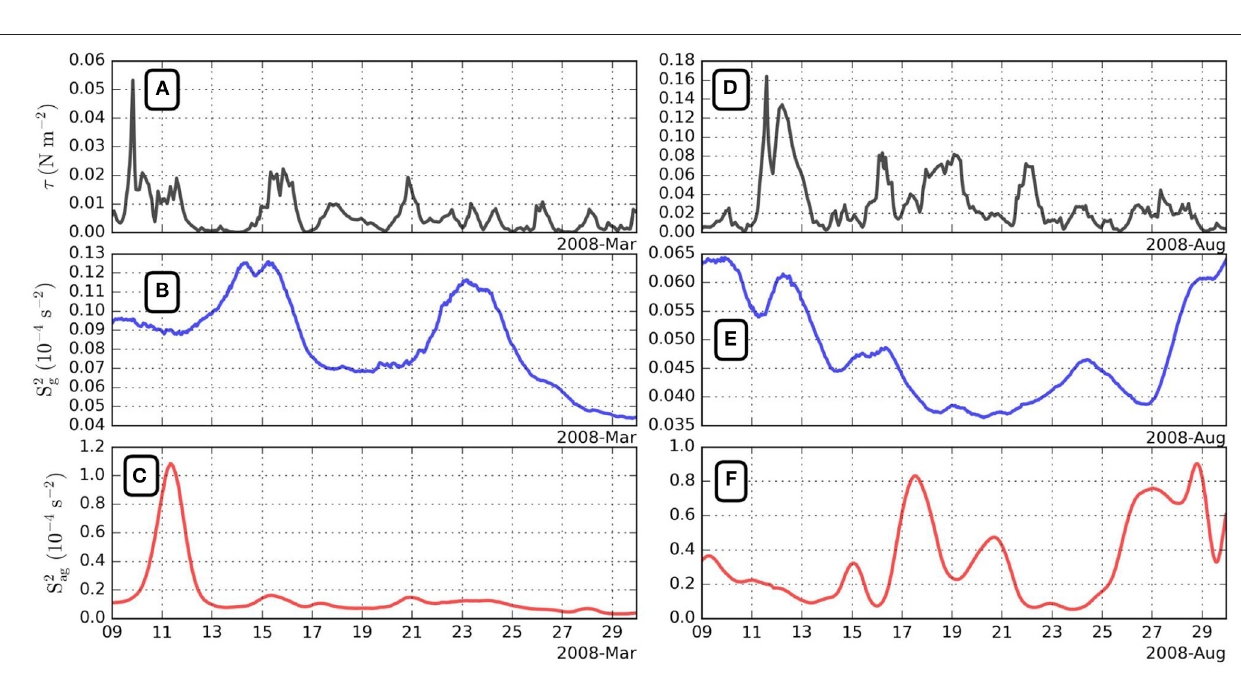
FIGURE 8 | Wind stress intensity in March (A) and in August (D) . Geostrophic shear in March (B) and in August (E) . Ageostrophic shear in March (C) and in August (F) . These quantities are averaged over the box shown in Figure 7 and between two isopycnals as explained in the